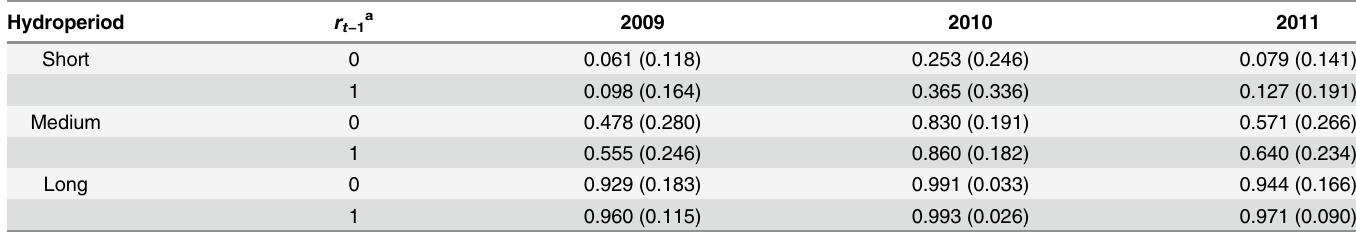
At the end of each iteration, we determined whether the metapopulation went quasi-extinct during the 100 year time horizon, and if so, the year of extinction was recorded. In all cases, we recorded the number of pools producing metamorphs in each year. To summarize all 1,000 Table 2. Means (SD) of posterior predictive distributions of the probability of vernal pools supporting wood frog breeding ( c ^ 1 ) at Rock Creek National Park, Washington, DC, USA.